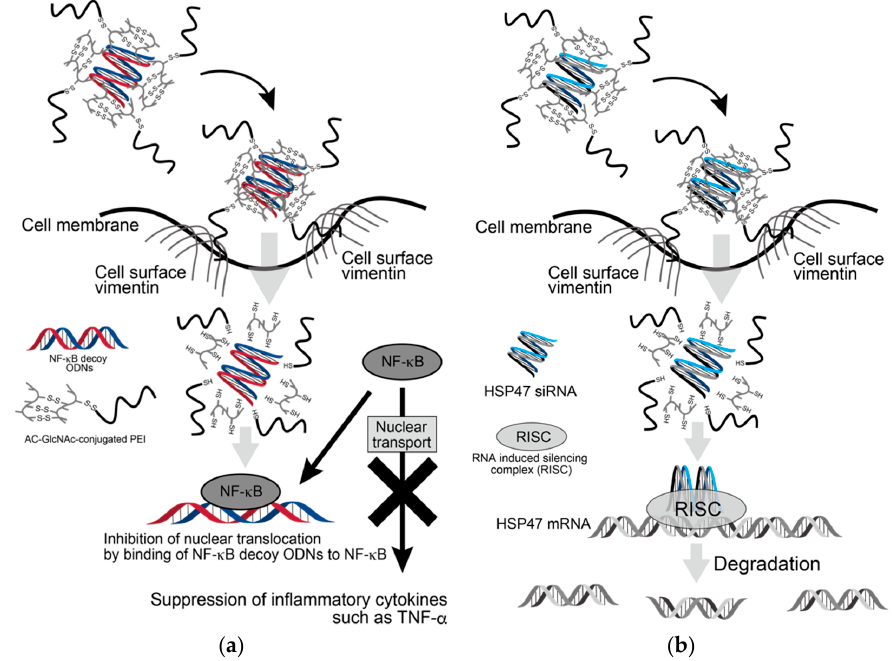
Figure 8. Scheme of delivery of oligonucleotides (ODNs) and siRNA to cytoplasm by AC-GlcNAc-conjugated PEI. ( a ) Suppression of inflammatory cytokines such as TNF- α by incorporating AC-GlcNAc-conjugated polyethyleneimine (PEI)/NF- κ B decoy ODNs into LPS-stimulated normal human dermal fibroblasts (NHDFs), ( b ) downregulation of HSP47 by incorporating AC-GlcNAc-conjugated PEI/HSP47-siRNA into TGF- β -stimulated NHDFs.